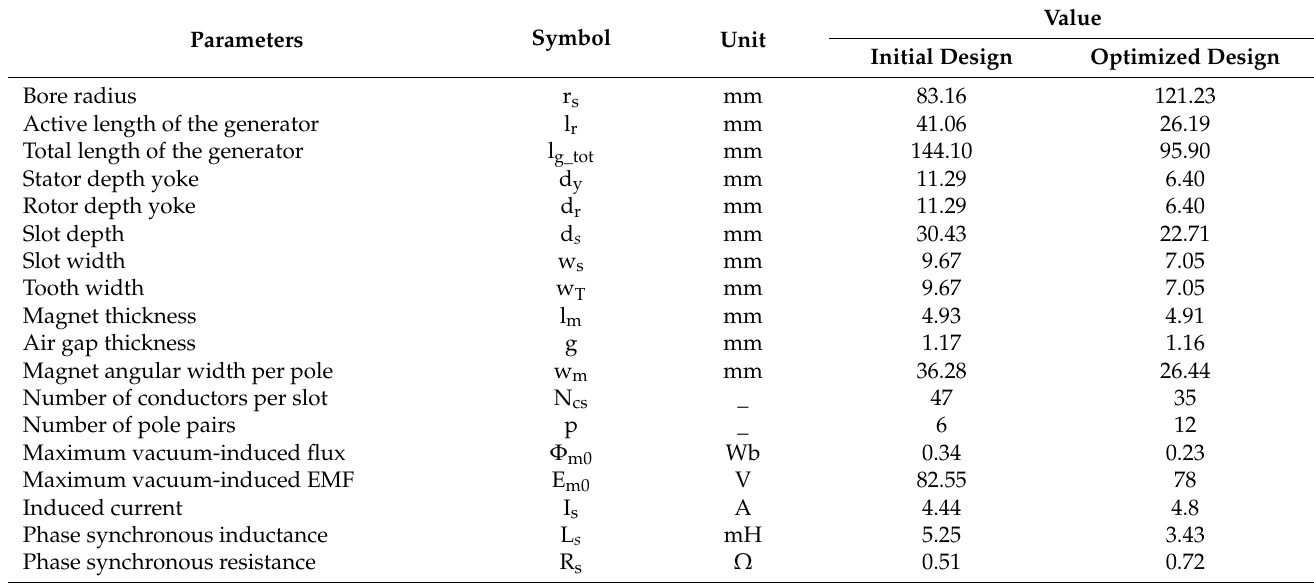
Table 4. Main parameters of PMSG before and after